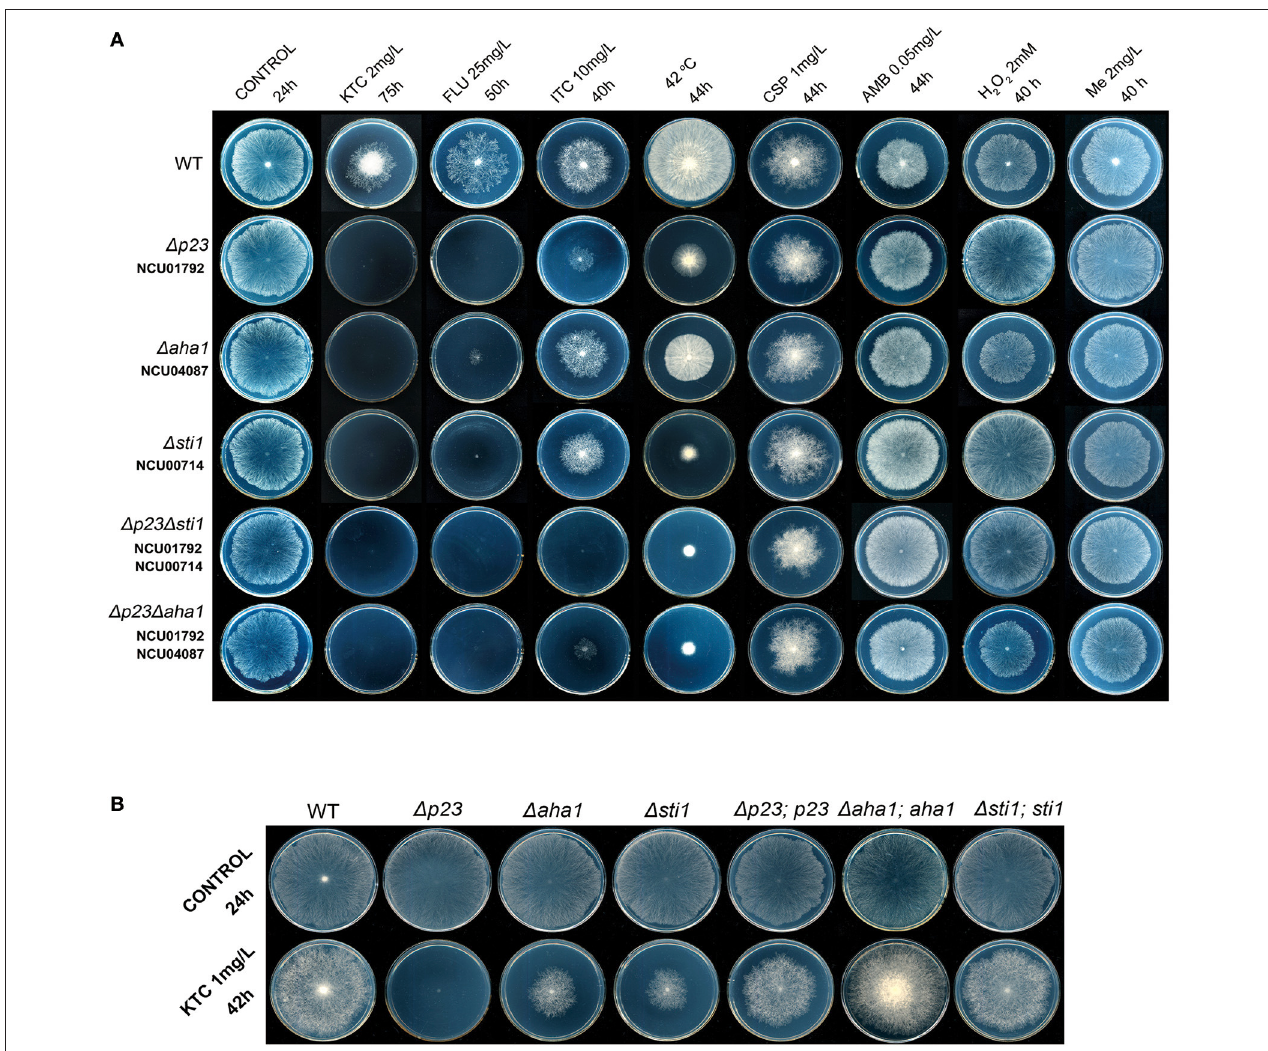
FIGURE 2 | Susceptibility tests of N. crassa to antifungal drugs, oxidants and heat stress. (A) Susceptibility tests of wild-type N. crassa , the knockout mutants of p23 , aha1 , sti1 ( ∆ p23 , ∆ aha1 , and ∆ sti1 ) and double deletion mutants ( ∆ p23 ∆ aha1 and ∆ p23 ∆ sti1 ) to antifungal drugs, oxidants and heat stress; (B) Susceptibility tests of the N. crassa knockout mutants ∆ p23 , ∆ aha1 , and ∆ sti1 and their complemented strains ∆ p23;p23 , ∆ aha1;aha1 , and ∆ sti1;sti1 to Ketoconazole. Two microliters of conidial suspension (2 × 10 6 conidia/ml) were inoculated in the center of plates ( 8 90mm) with or without antifungal drugs or oxidants, then incubated at 28 or 42 ◦ C (heat tests) for the indicated times. Each test was duplicated and the experiment was independently repeated at least three times. KTC, ketoconazole; FLU, fluconazole; ITC, itraconazole; CSP, caspofungin; AMB, amphotericin B; Me,